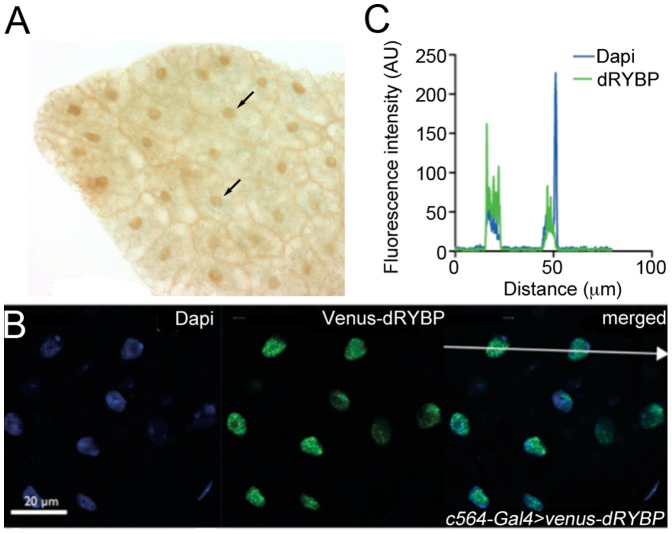
dRYBP localizes to the nuclei of adult fat body cells.(A) dRYBP protein is expressed in the nuclei of fat body cells (arrows). (B) Flies overexpressing Venus-dRYBP under the fat body specific driver c564-Gal4 were infected by pricking with Ecc15. Fat bodies were dissected 3 h after infection, fixed and stained with anti-GFP antibody and DAPI. Images are representative of several UAS-Venus-dRYBP insertion lines. (C) Fluorescence profile along arrow in (B) shows dRYBP is exclusively nuclear and excluded from nucleoli. AU (Arbitrary Units). Scale bar denotes 20 µm.